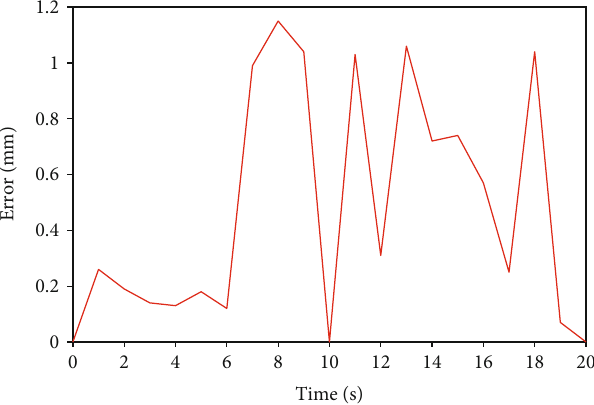
Figure 15: Axial displacement error of BP neural network PID controller.